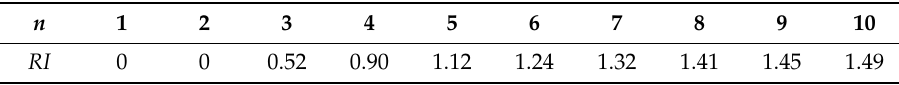
Table 1. The table of random index ( RI ) [37].